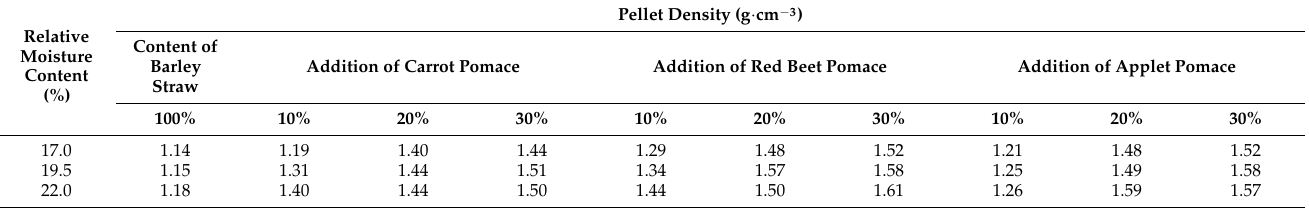
Table 1. Influence of substrate relative moisture content and substrate content on the density of obtained pellet. Relative Moisture Content